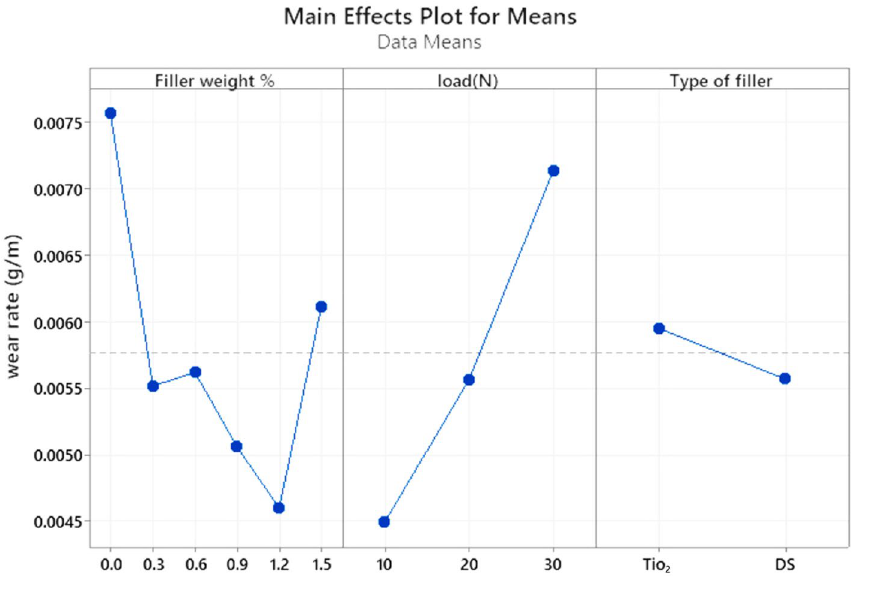
Figure 11. Main effects plot for mean wear